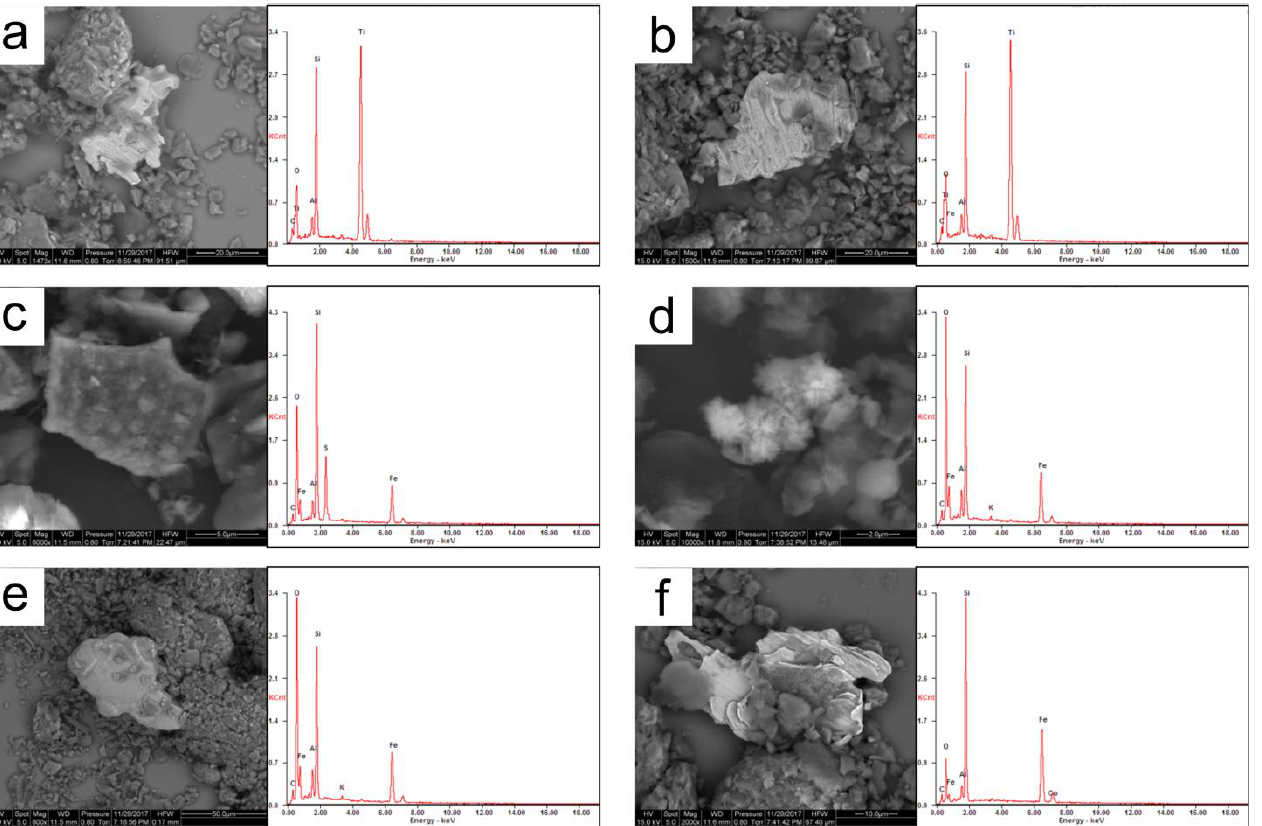
Figure 5. SEM microphotographs and EDX spectra of suspended particulate matters in the Yellow Sea. ( a ) Anatase; ( b ) rutile; ( c ) pyrrhotite; ( d ) goethite; ( e , f ) hematite.